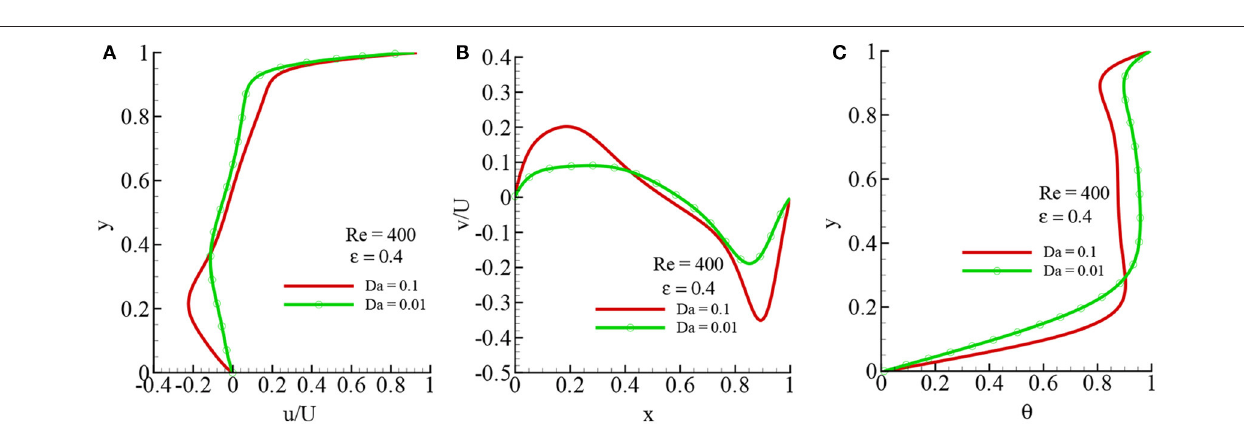
1,000 and isotherms (bottom): (C) Re =